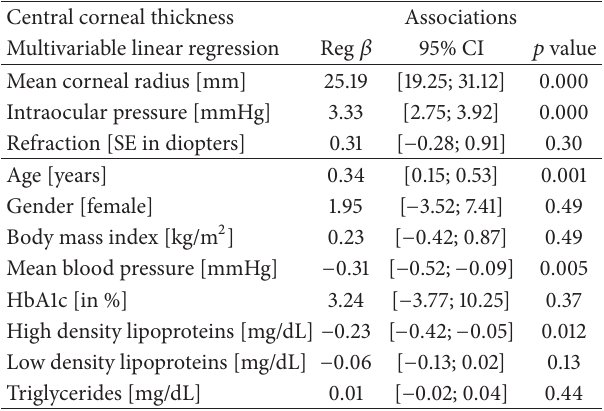
Table 2: Association analysis of SD-OCT based central corneal thickness on ocular and systemic parameters using a generalized estimating equations model. Regression coefficient Beta (Reg 𝛽 ), 95% confidential interval (95% CI), and 𝑝